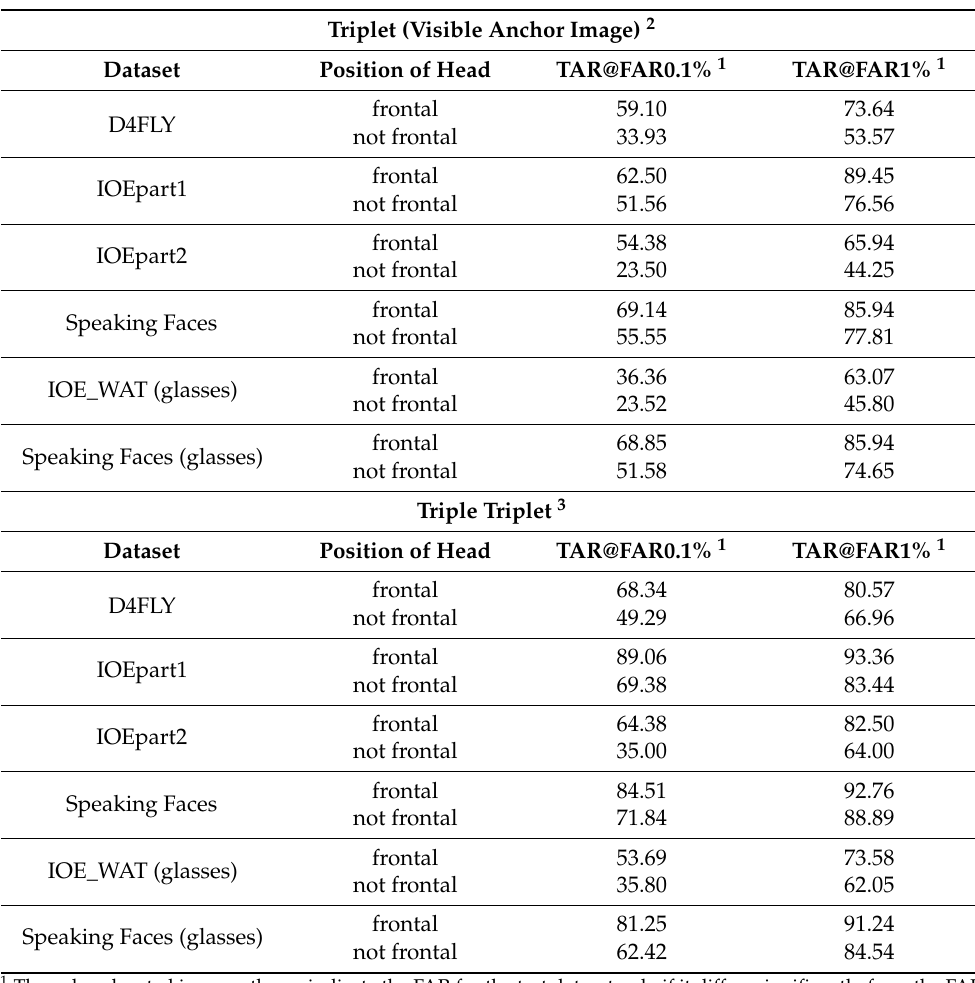
Table 8. Performance of triple triplet algorithms according to different head